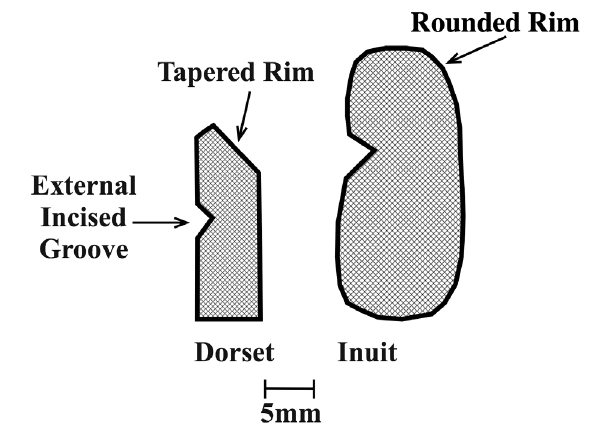
Figure 5. Cross section attributes of Dorset drum fragments from Button Point (left) contrasted with Historic Inuit drums in the Canadian Museum of History